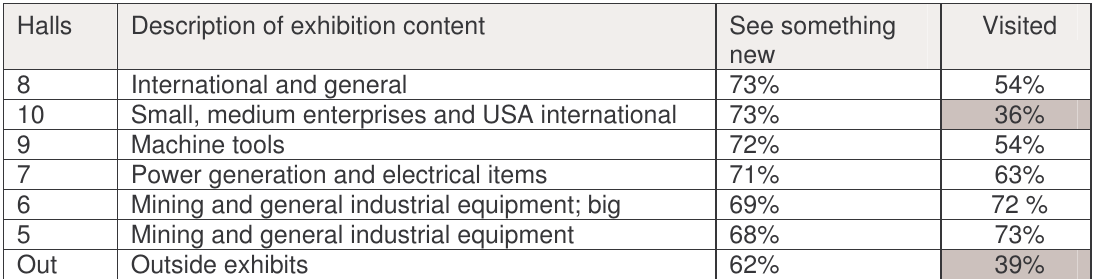
Table 5: See something new in their field of work at different exhibition halls in 2006